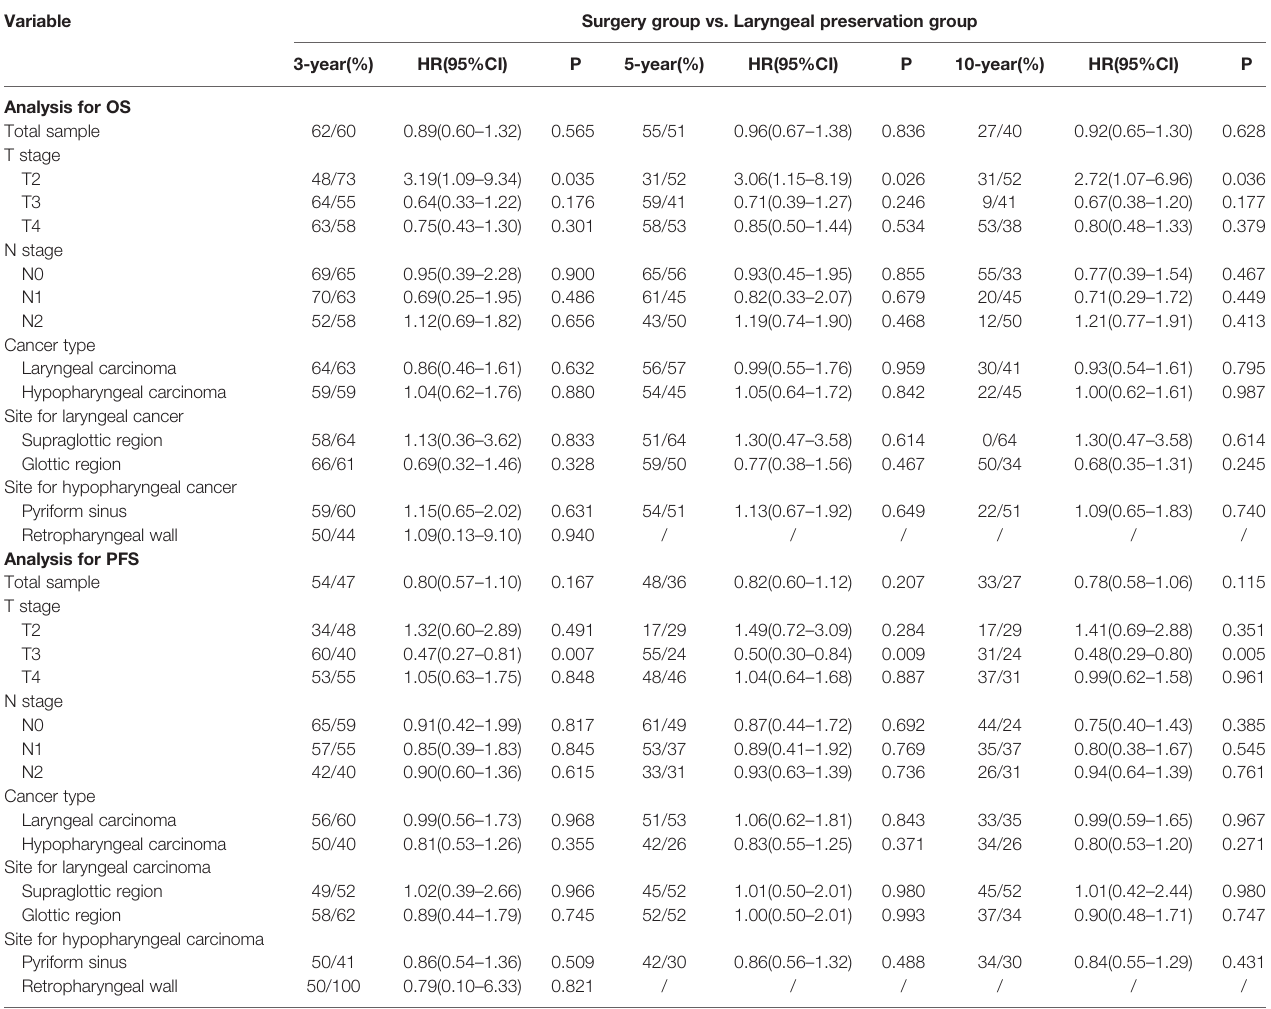
TABLE 5 | Univariate analysis of survival data between the surgery group and the larynx preservation group. Variable